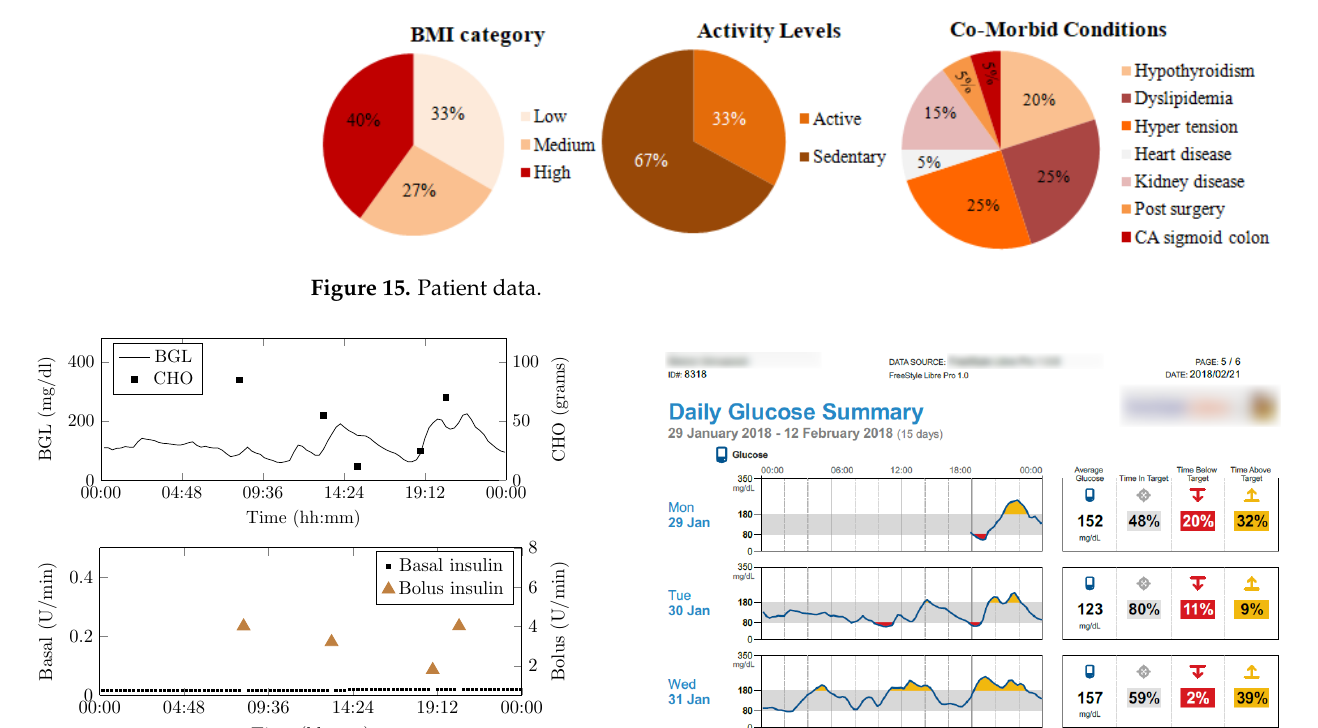
Figure 16. Snap-shot of one day data collected from a patient.